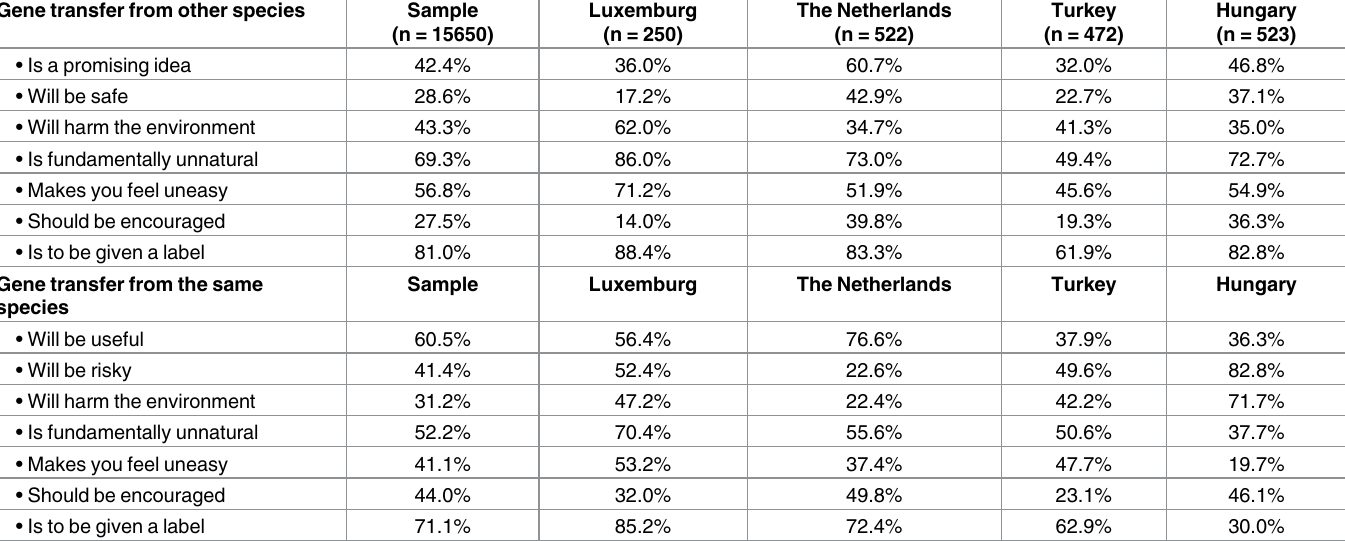
Table 1. Rates of agreement with different proposals concerning the genetic manipulation of apple